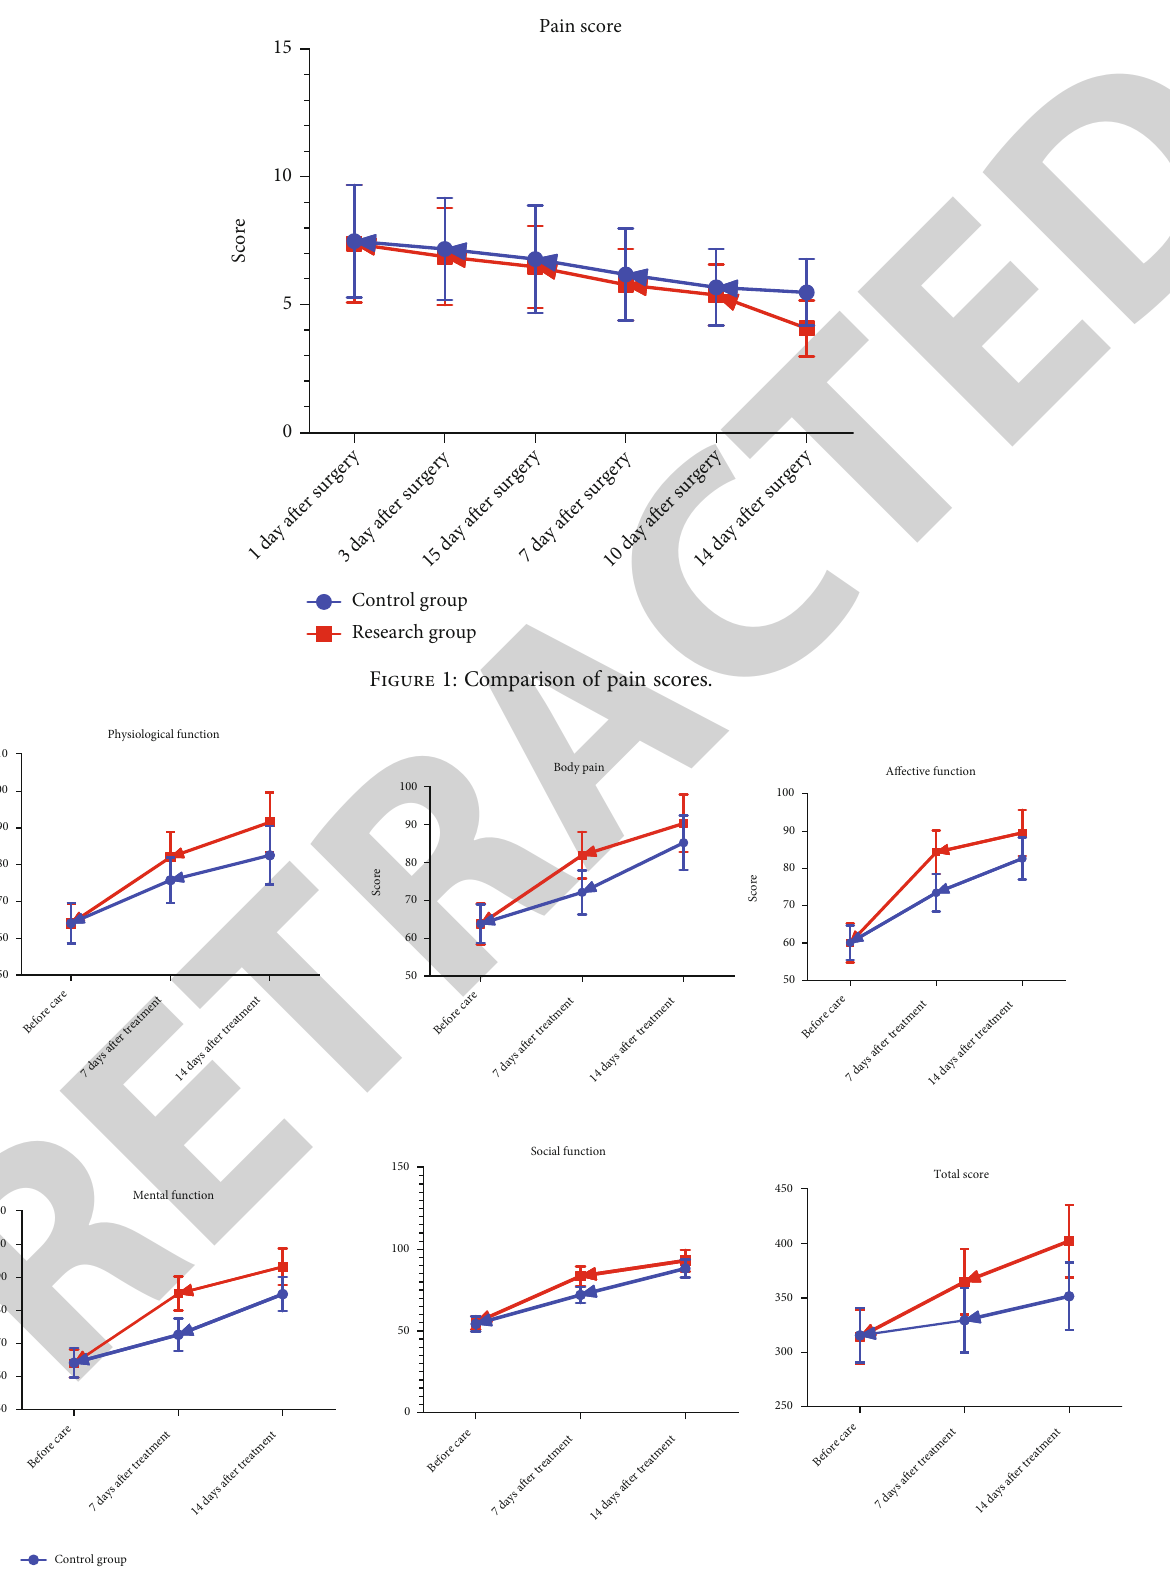
Figure 1: Comparison of pain